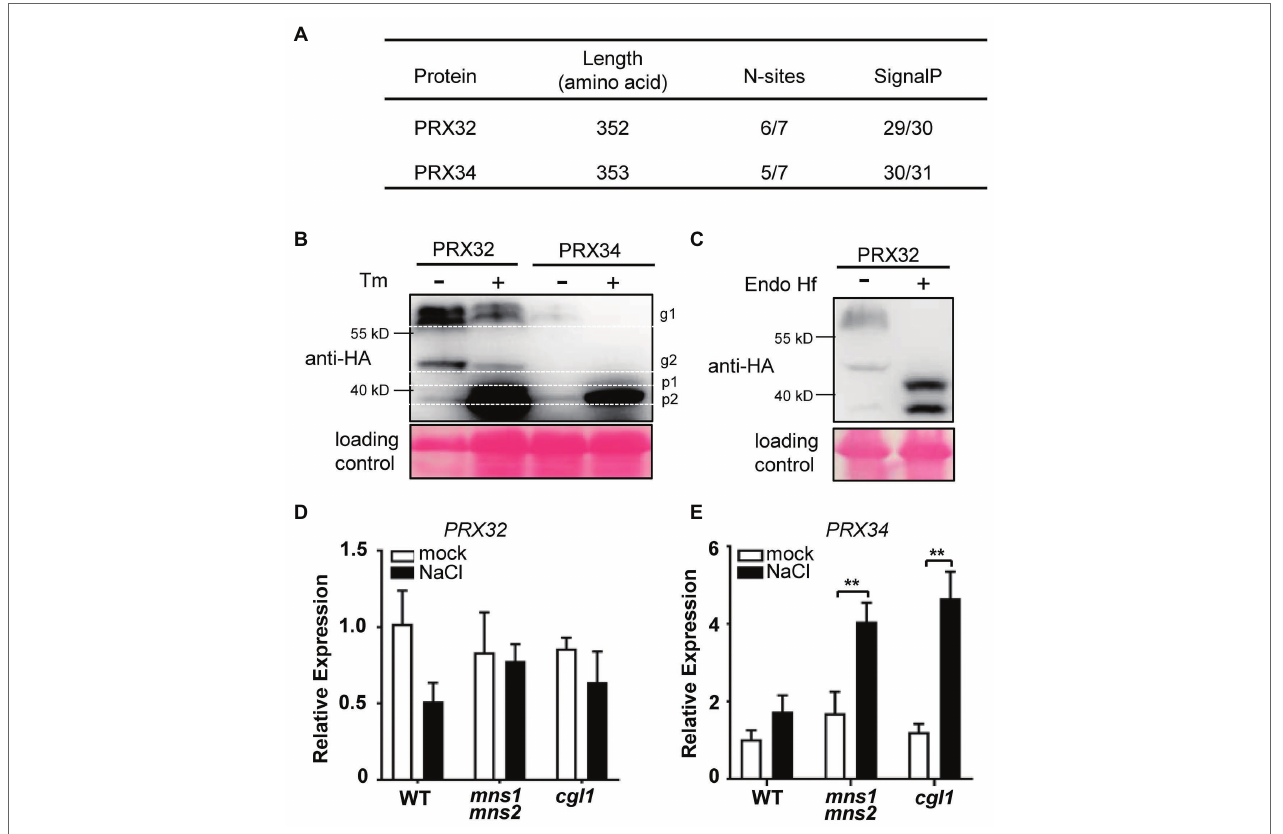
FIGURE 5 | PRX32 and PRX34 are N-glycosylated, and their expressions are responsive to salt stress. (A) Prediction of N-glycosylation sites and signal peptides in PRX32 and PRX34. (B) N-glycosylation analysis of PRX32 and PRX34 proteins by tunicamycin treatment. PRX32-HA and PRX34-HA were transiently expressed in tobacco leaves in the absence or presence of tunicamycin and analyzed by immunoblots using anti-HA antibodies. g1 and g2 indicated two glycosylated bands; p1 and p2 represented two non-glycosylated bands. Ponceau S staining served as a loading control. The molecular weights of PRX32 and PRX34 are both 39 kD. (C) N-glycan analysis of PRX32 by Endo H digestion. The recombinant protein PRX32-HA was transiently expressed in tobacco leaves. After digested with glycosidase Endo Hf, the total proteins were separated on SDS-PAGE and detected with anti-HA antibodies. Ponceau S staining served as a loading control. (D,E) Quantitative real-time PCR (qPCR) analysis of gene expression in response to salt stress. Total RNAs were extracted from 2-week-old seedlings treated with or without salt stress described in Figure 1 . The expression levels of PRX32 (D) and PRX34 (E) were analyzed by qPCR. **Indicates a significant difference at p <